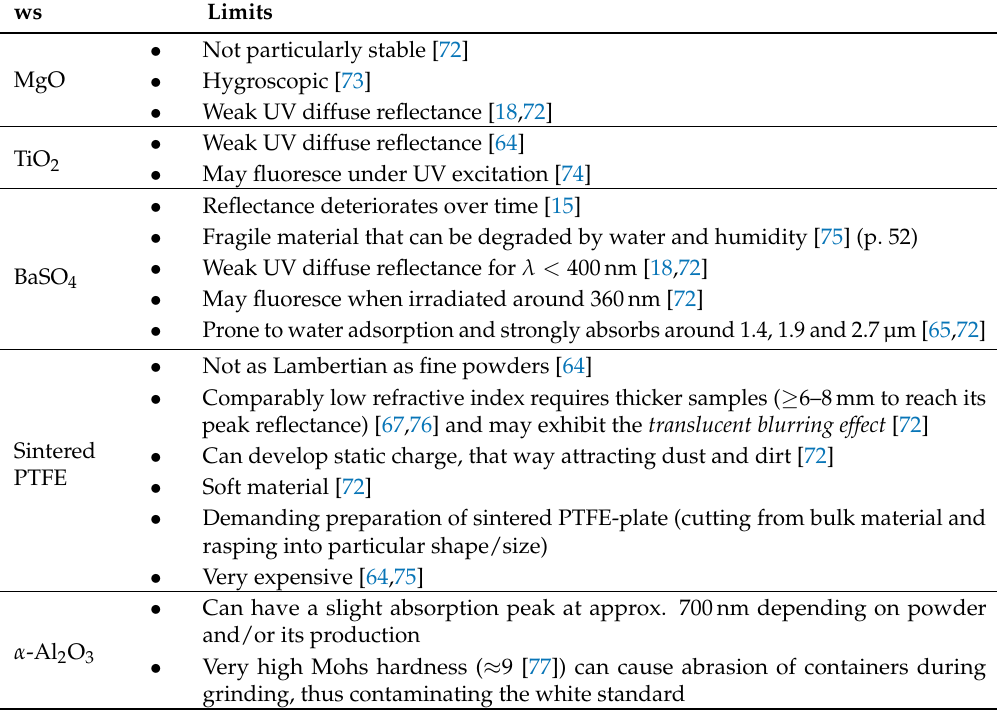
Table 2. Materials commonly applied for white standards (ws) in diffuse reflectance measurements with their respective optical and material properties important for diffuse reflectance spectroscopy